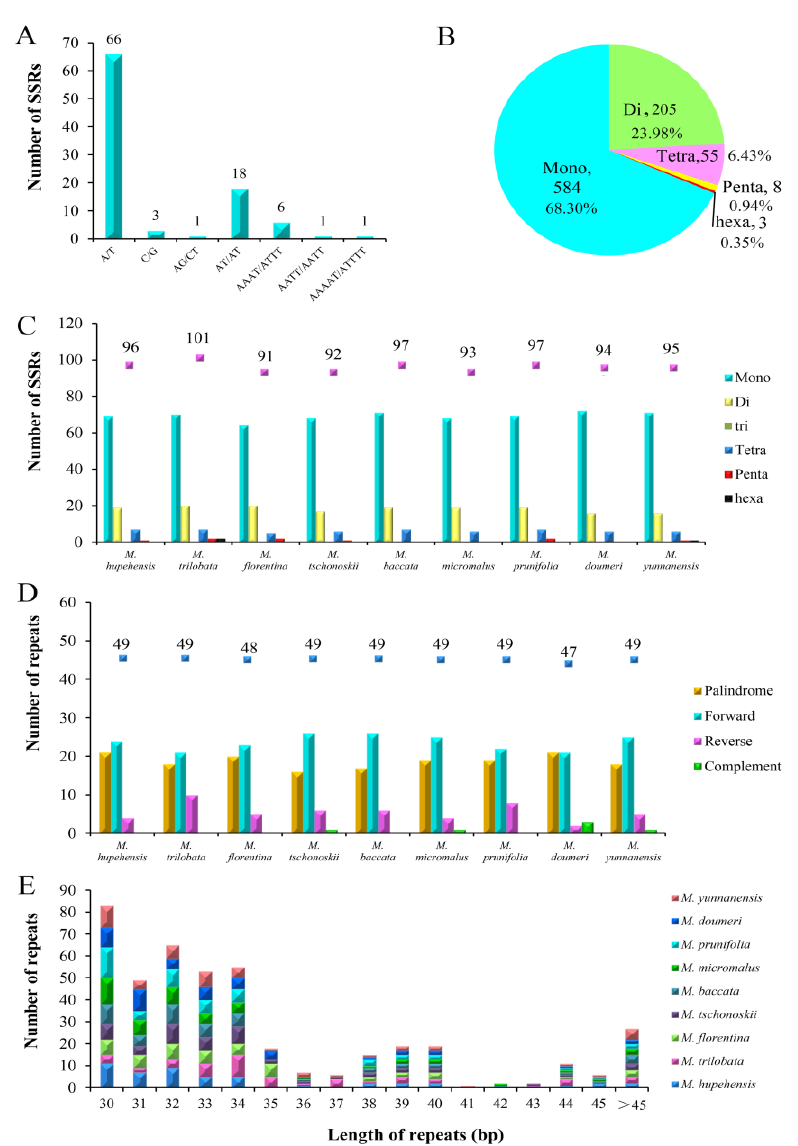
Figure 3. Repeat analyses. ( A ) Repeat unit and amounts of SSR in the M. hupehensis cp genome. ( B ) Presence of different SSR types in all of the SSRs of nine Malus chloroplast genomes. ( C ) SSRs in the nine Malus cp genomes. ( D ) Repeated sequences in the nine Malus cp genomes. ( E ) Repeat frequency of four types by length in the nine Malus chloroplast genomes.